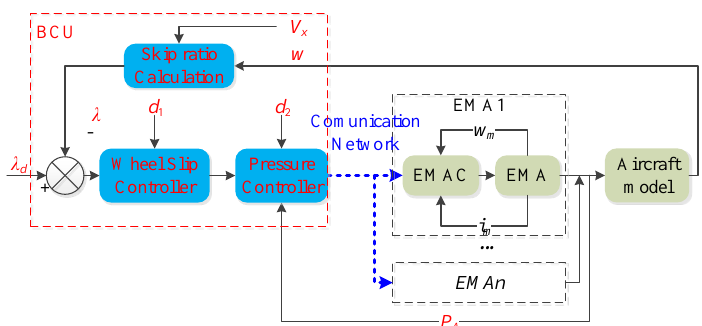
Figure 4. Control block diagram of an aircraft AEA anti-skid braking system based on network communication.